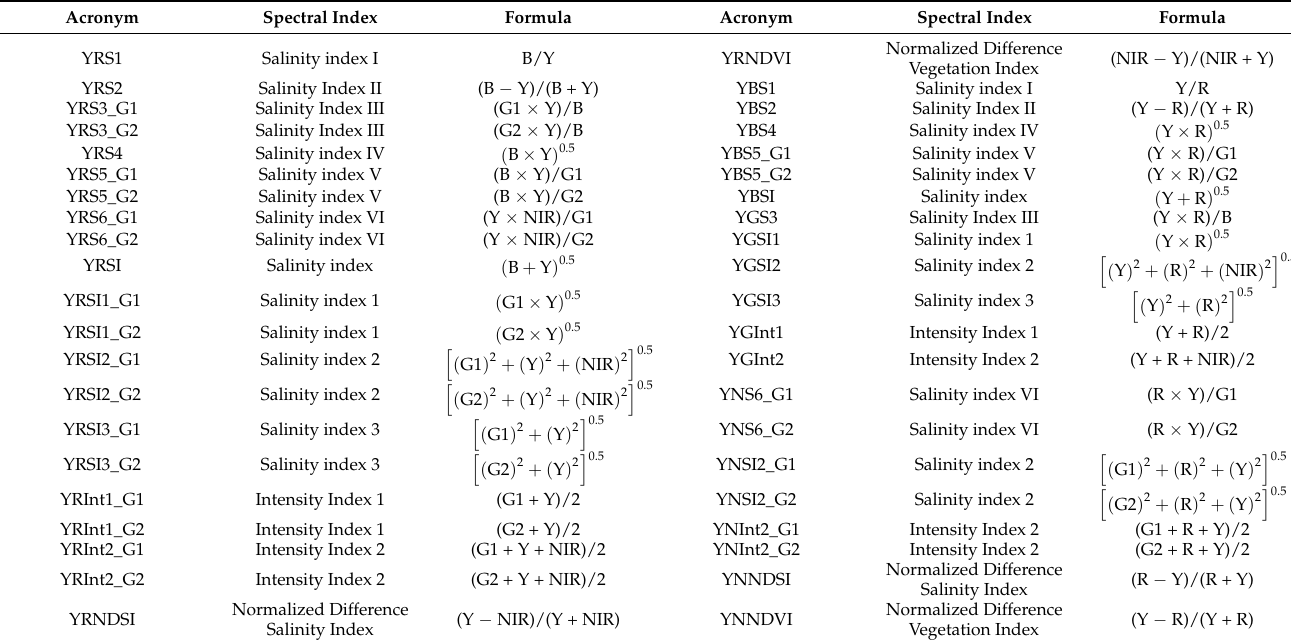
Table 4. The newly proposed yellow spectral